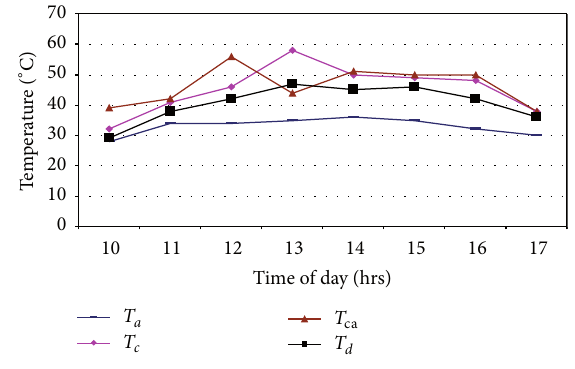
Figure 3: Ambient, collector, collector case and food cabinet temperatures for Day